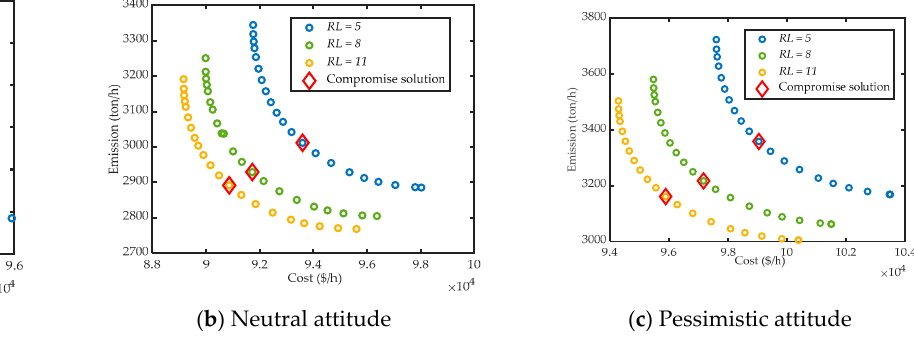
Figure 8. Pareto fronts in terms of risk levels.